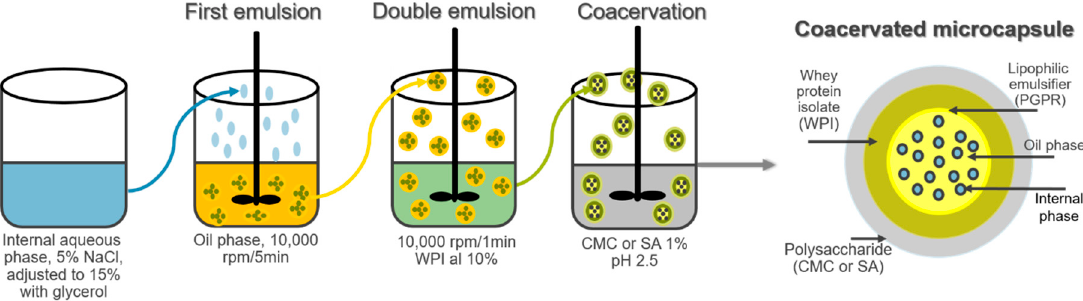
Figure 1. Stages for the preparation of the microcapsule. Note: CMC = sodium carboxymethylcellulose; SA = sodium alginate. PGPR = polyglycerol polyricinoleate.